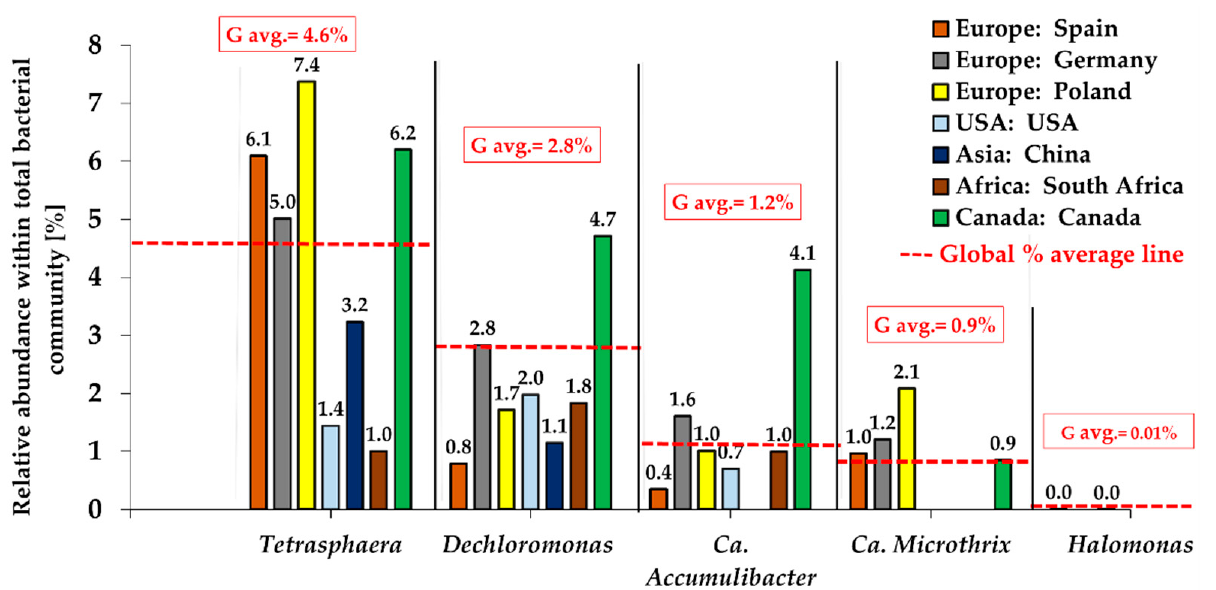
Figure 3. Overview of the global abundance of the denitrifying PAOs within the general microbial community in EBPR systems (based on data from [4,34]).